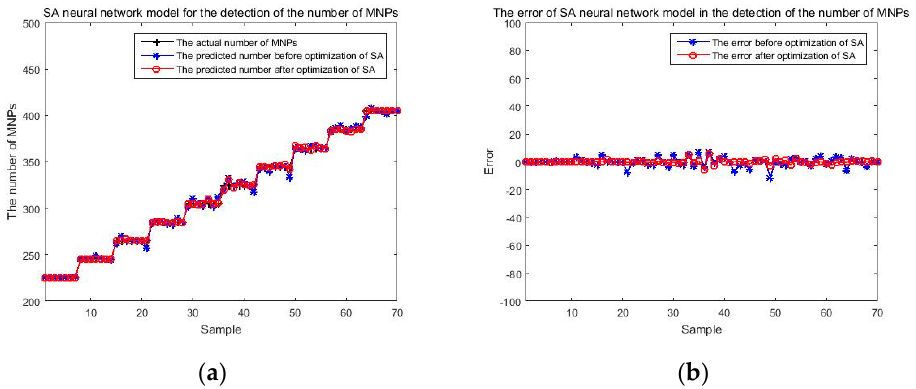
Figure 16. Comparison of prediction effect of SA neural network model before and after the optimization of SA: ( a ) comparison of prediction results of SA neural network model before and after optimization and ( b ) comparison of prediction error of SA neural network model before and after optimization.